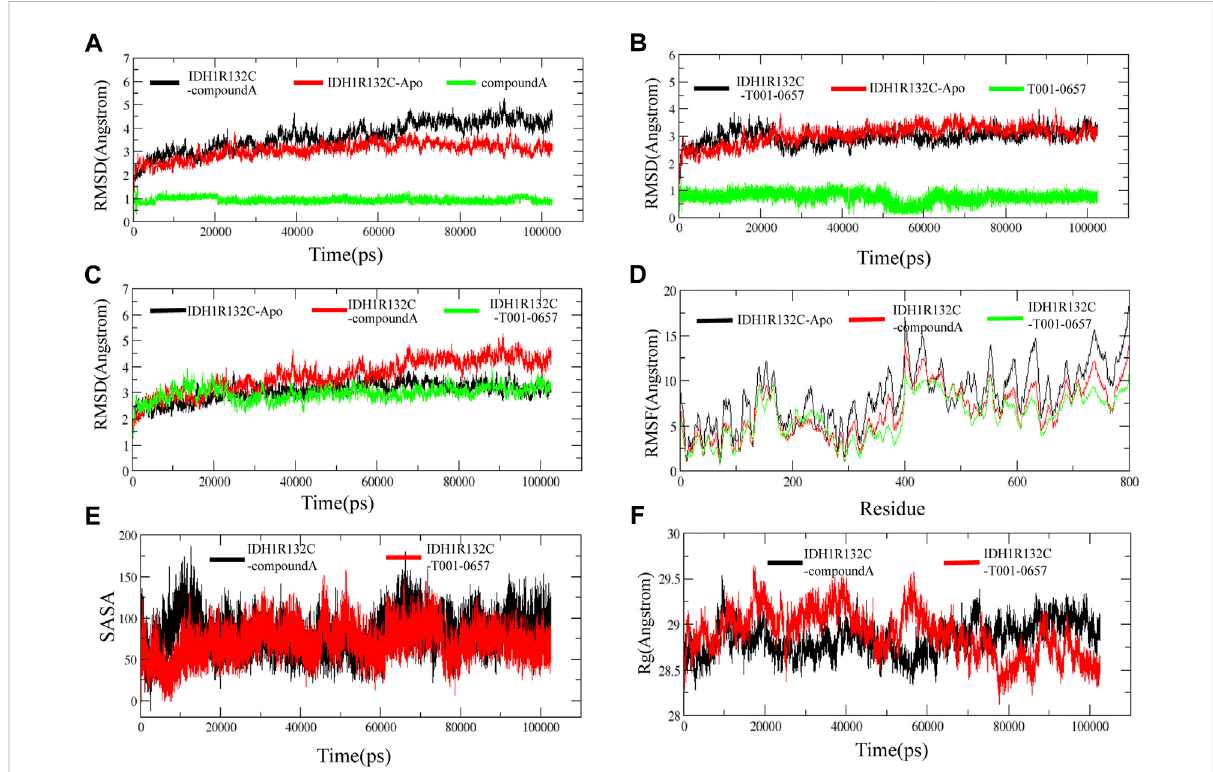
FIGURE 5 Stability of the IDH1 inhibitor system. (A) Root-mean-square deviation (RMSD) of the backbone atom of IDH 1-R132C, the complex formed by IDH 1-R132C with compound A and the heavy atom of compound A. (B) The RMSD of the backbone atom of IDH 1-R132C, the complex formed by IDH 1-R132CwithT001-0657andtheheavyatomofT001-0657. (C) TheRMSDofthebackboneatomof IDH1 -R132C,thecomplexformedby IDH1 - R132C with compound A, and the complex formed by IDH1 -R132C with T001-0657. (D) The root-mean-square fl uctuation of the backbone atom of IDH1 -R132C and IDH1 -R132C in the complex with compound A and T001-0657. (E) The solvent-accessible surface area analysis of compound A and T001-0657 bound with IDH1 -R132C. (F) The mass-weighted radius of gyration.